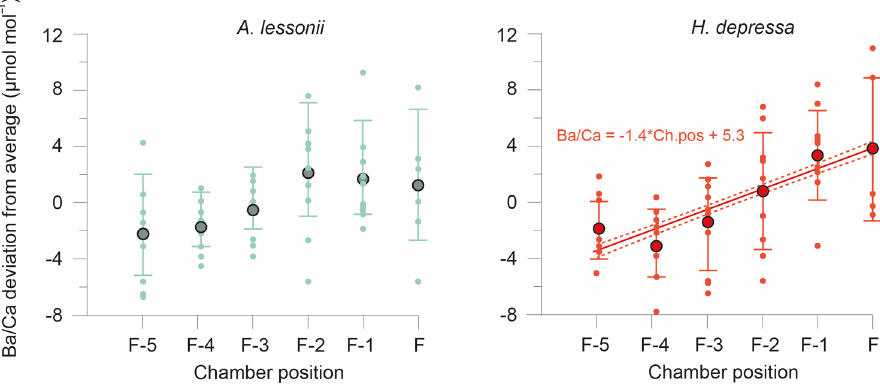
Figure 3. Average (large, darker shaded circles) and single-chamber measurement (lighter circles) Ba / Ca cc ratios, expressed as their devia- tion from the mean shell Ba / Ca cc for A. lessonii (left) and H. depressa . Error bars represent the standard deviation of the mean; the dashed lines in the right panel indicate the 95% confidence intervals for the linear